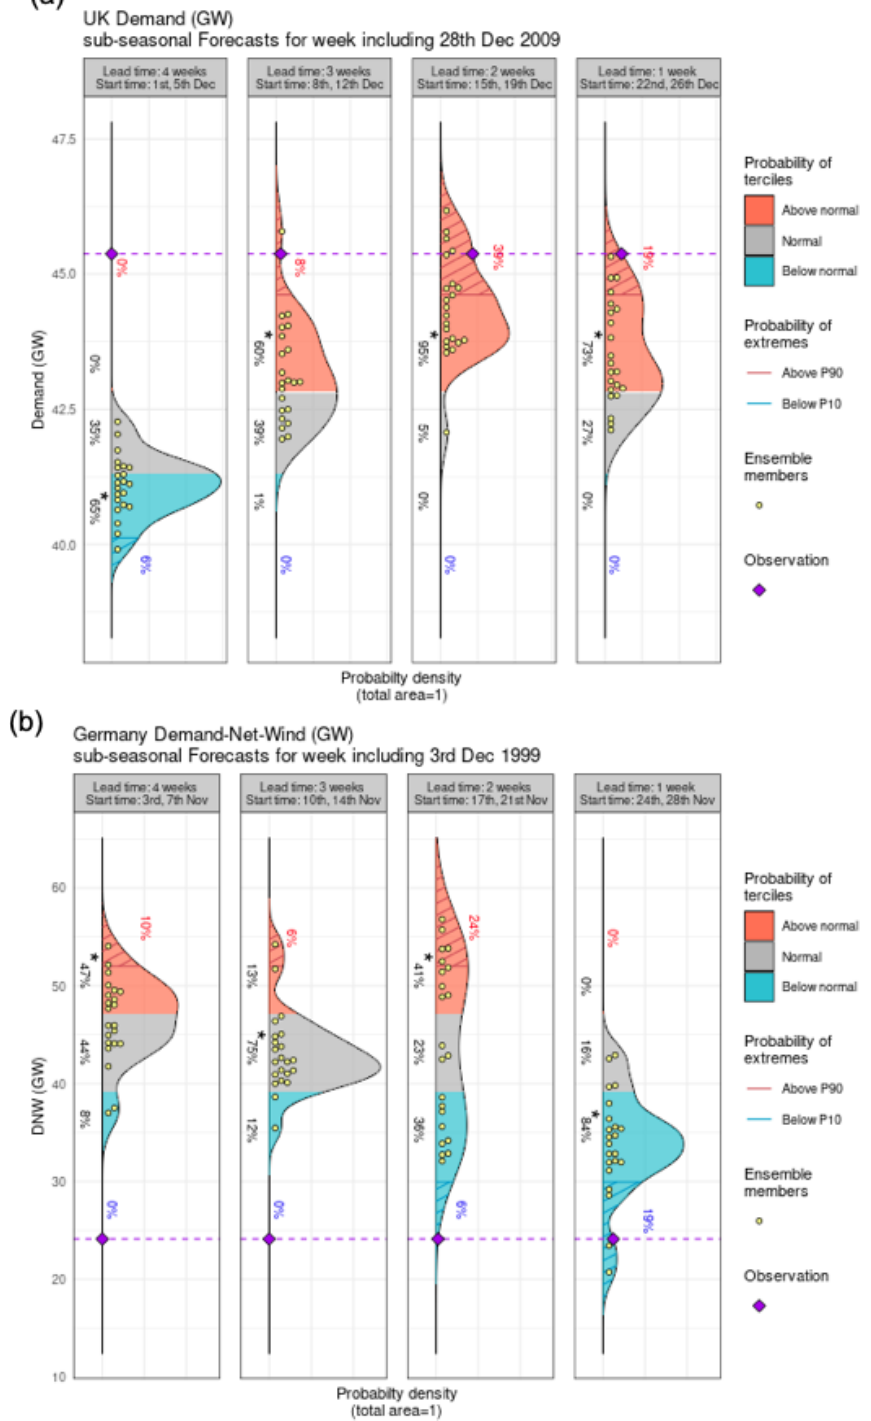
Figure 4. Weekly-mean forecasts verifying for the case study events of (a) UK high demand, 28 December 2009 and (b) Storm Anatol 2–8 December 1999. Purple dots give the weekly mean verification from ERA5. From left to right are the forecasts launched from lead weeks 4 to 1. Definitions of the lead weeks are given in Sect. 2. Shaded areas represent climatological terciles with hatching showing the 10th and 90th percentiles calculated from 1979–2019 in